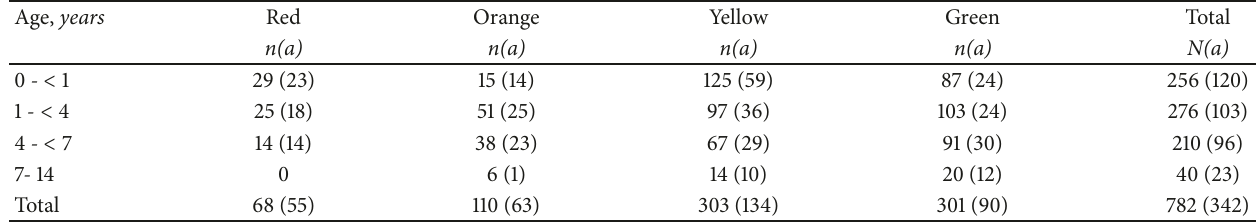
Table 2: The distribution of assigned triage priority by age groups.